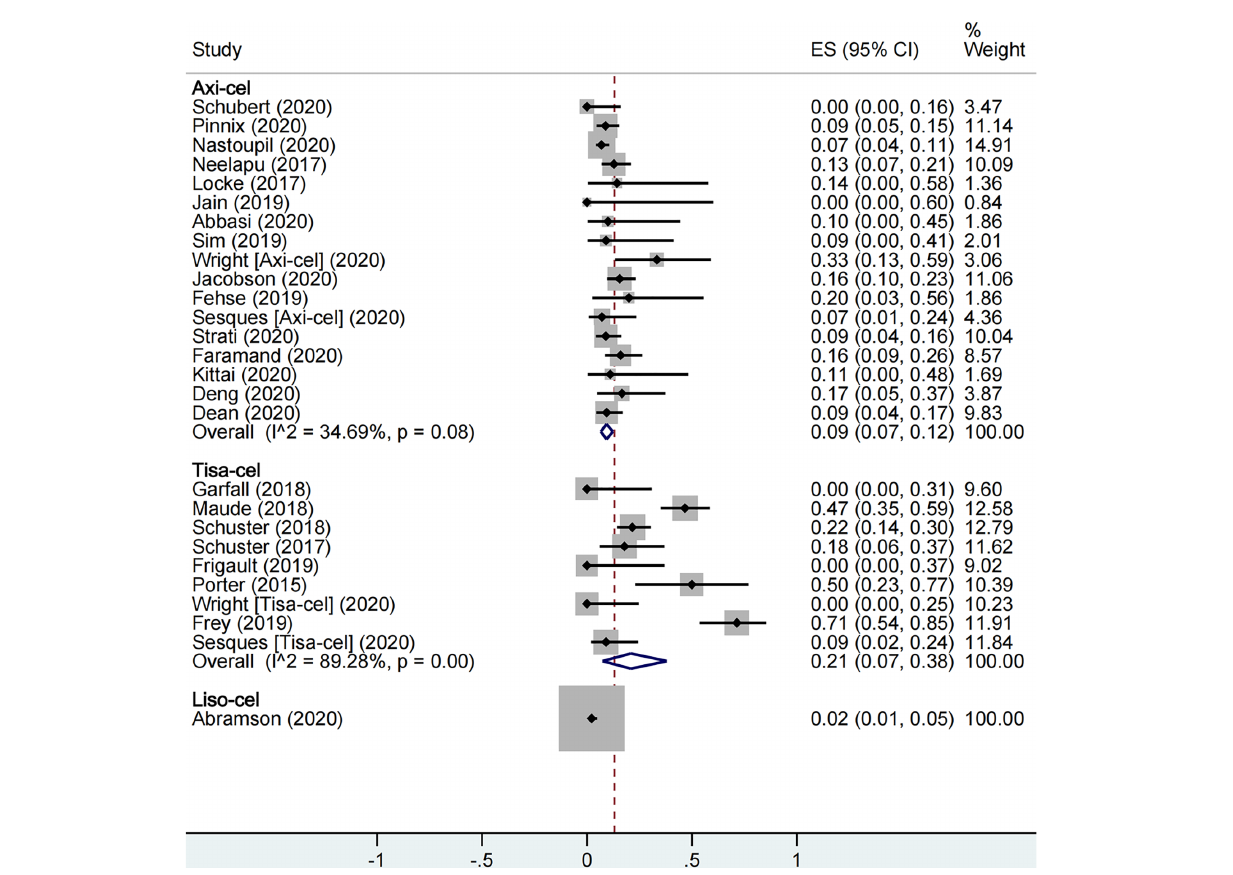
FIGURE 4 | The forest plot of total severe cytokine release syndrome rate of each